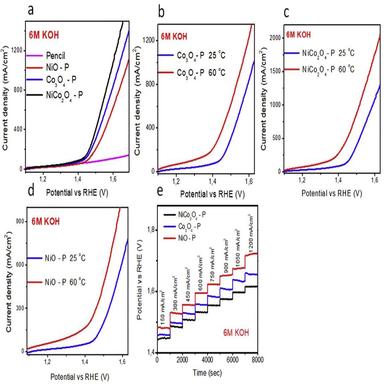
a. LSV curves of bare graphite pencil, NiOeP, Co3O4eP, NiCo2O4eP, at a scan rate of 5 mVs-1 in 6.0 M KOH at 25 C, b. LSV curves of Co3O4eP at a scan rate of 5 mVs-1 in 6.0 M KOH at 25 C and 60 C, c. LSV curves NiCo2O4eP at a scan rate of 5 mVs-1 in 6.0 M KOH at 25 C and 60 C, d. LSV curves of NiOeP at a scan rate of 5 mVs-1 in 6.0 M KOH at 25 C and 60 C, e. Multistep current chronoamperometric response of NiOeP, Co3O4eP, NiCo2O4eP in 6.0 M KOH at the beginning of 150 mAcm¡2 during each step and time interv